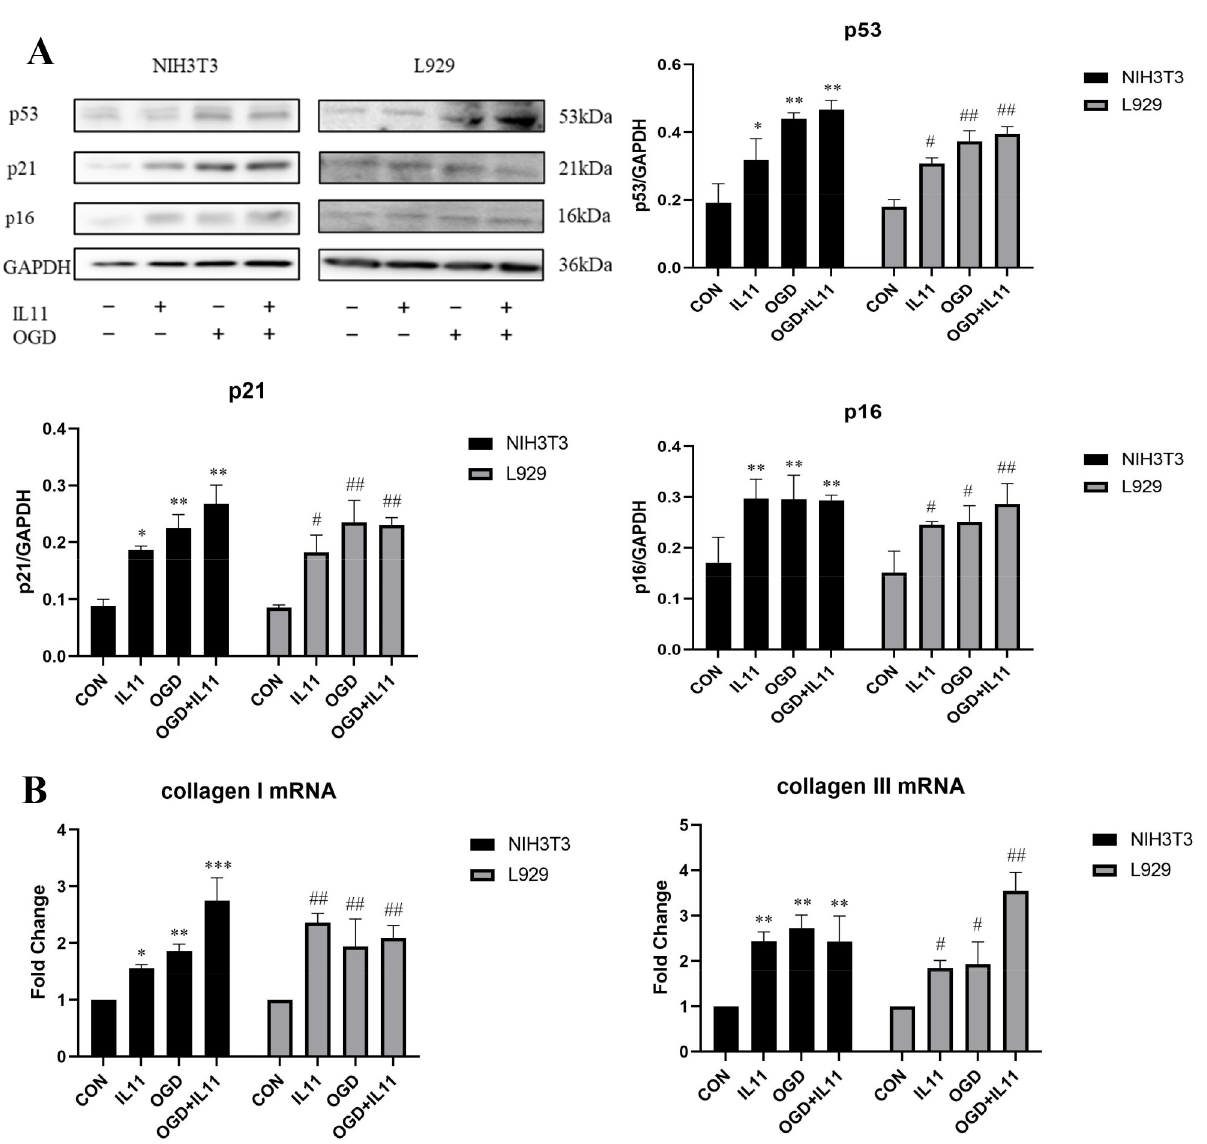
Figure 5. rmIL11 promoted fibroblast senescence and collagen expression. ( A ) Western blot analysis and densitometric analysis of p53, p21, and p16 protein levels after supplementing rmIL11 in OGD-induced NIH3T3 and L929 cell senescence. ( B ) mRNA expression estimated by RT-PCR for collagen I and collagen III after supplementing rmIL11 in NIH3T3 cells and L929 cells. OGD—oxygen–glucose deprivation; CON—control. The results are presented as the means ± SDs, and Student’s t -test was used to determine the p -value. * p < 0.05, ** p < 0.01, and *** p < 0.001, compared with CON group in NIH3T3 cells; # p < 0.05 and ## p < 0.01, compared with CON group in L929 cells.